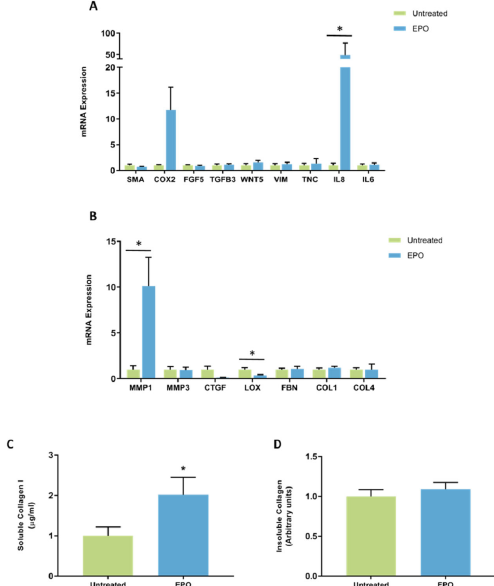
Figure 6. The effect of EPO on mRNA expression and collagen production in mammary fibroblasts. Messenger RNA expression of cancer-associated genes ( A ) and genes involved in extracellular matrix regulation and collagen production ( B ) measured by RT-PCR in human mammary fibroblasts following treatment with 2.5 µ g/mL of EPO for 72 h. mRNA expression normalised to HPRT1 expression and presented as relative expression where the average for untreated controls is 1. Collagen production was measured using collagen 1 ELISA ( C ) and insoluble collagen measured by sirius red staining ( D ). Data presented as mean + SEM with statistical analysis performed using a linear mixed- effects model Tukey’s post hoc comparison. Statistical significance indicated by * when p <